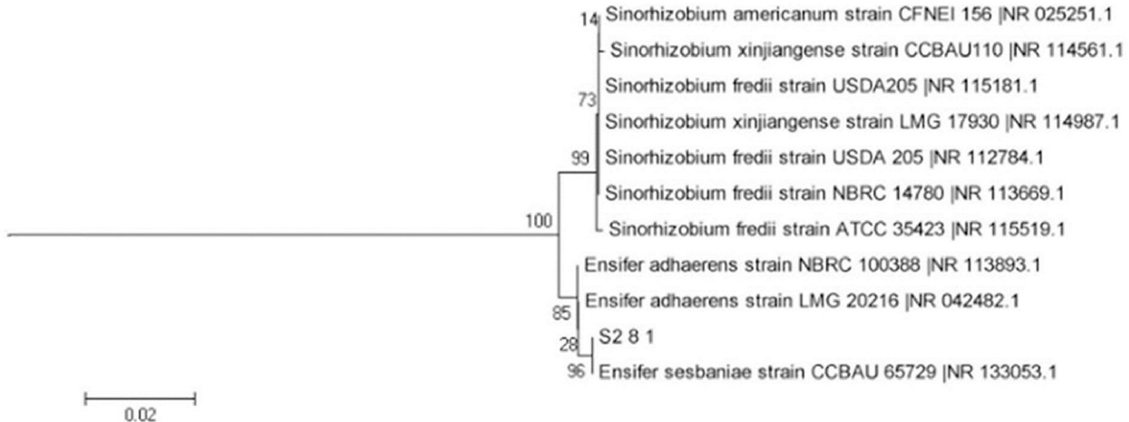
Figure 3. Phylogenetic tree based on the 16S rDNA sequence of 1 AOB strains. The S2_8_1 in the figure is the strains that has been isolated and screened in the present study.